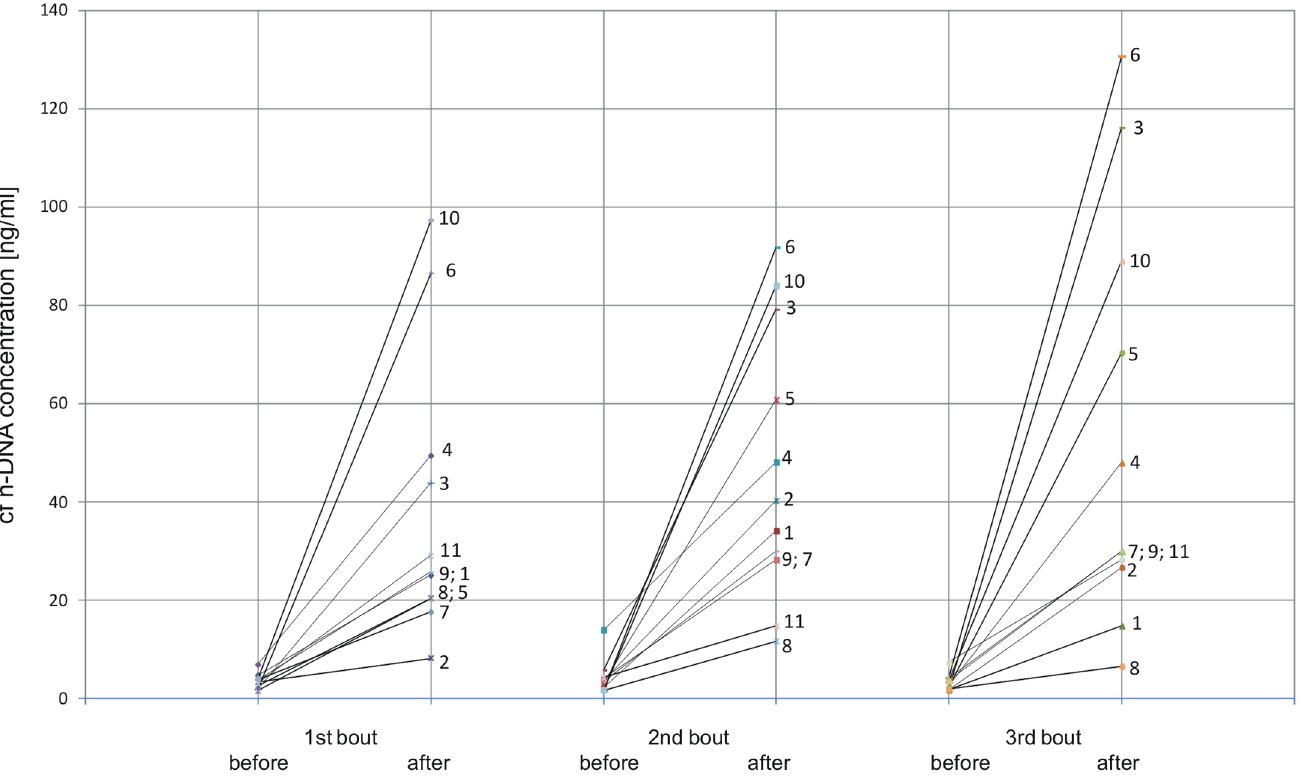
Fig 2. Individual cf n-DNA responses to each of three repeated bouts of exhaustive treadmill exerciseseparated by three days of resting. Eleven average-trained men executedthree repeatedtreadmill exercise tests to exhaustionat speed corresponding to 70% of personalVO 2 max and cf n-DNA was determinedin pre- and post-exercise bloodsamples. The first studied men is marked by 1 and the last one is marked by 11. The same numbersat line segments representresponsesof the same